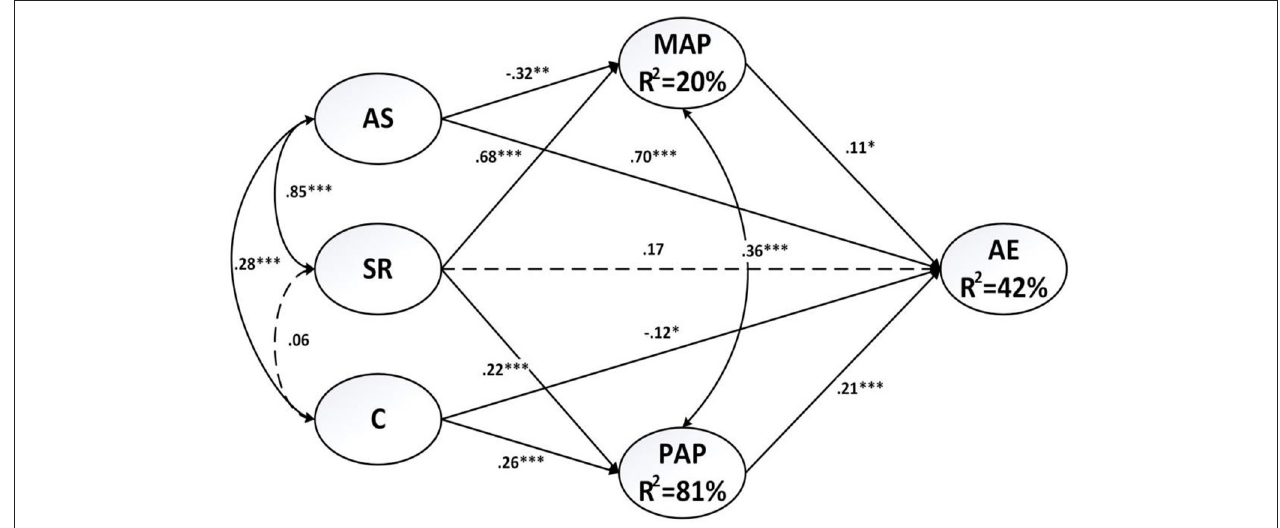
FIGURE 2 | Results of testing the structural model. * p < 0.05, ** p < 0.01, and *** p < 0.001. The solid lines indicate significant paths; the dotted lines indicate non-significant paths. AS, perceived autonomy support; SR, perceived social relatedness; C, perceived controlling; MAP, mastery-approach goals; PAP, performance-approach goals; AE, agentic